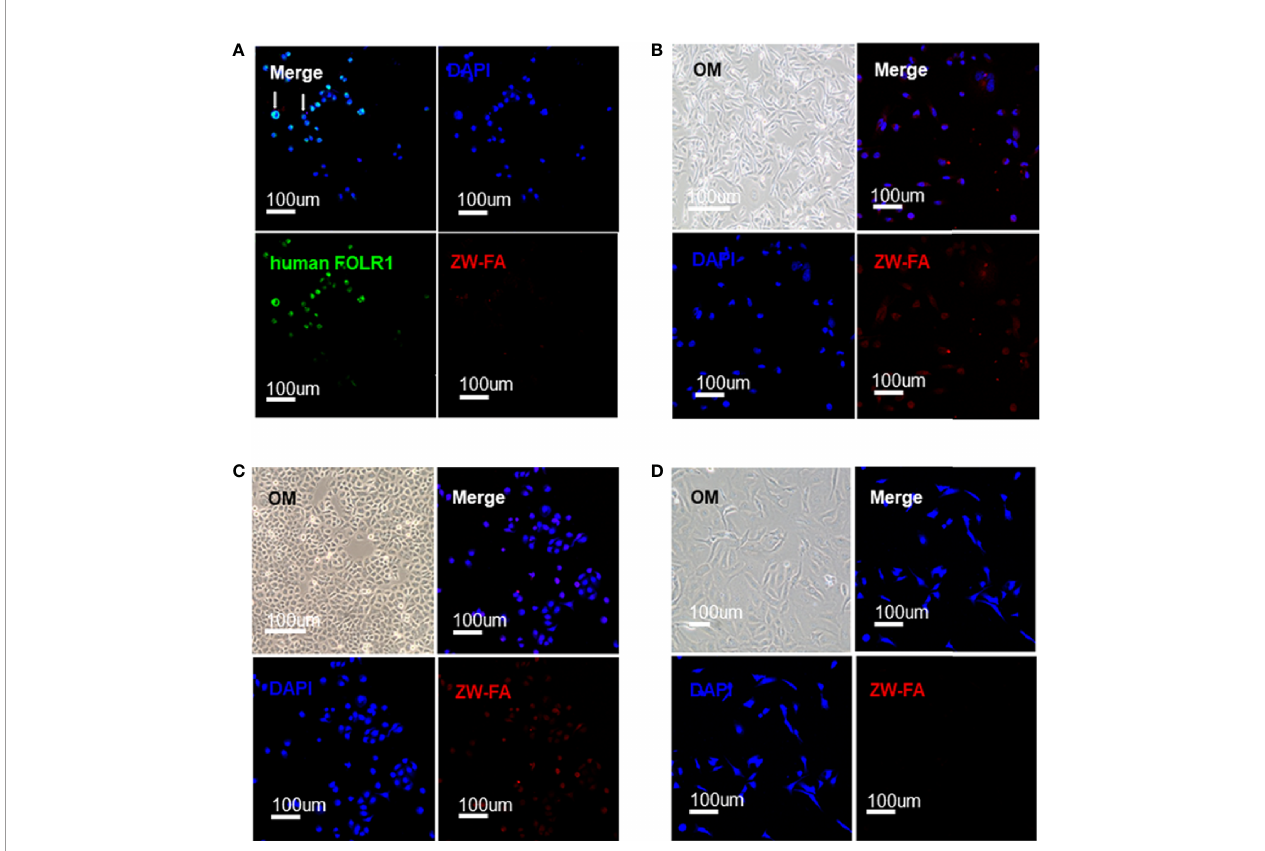
FIGURE 2 | Targeting veri fi cation. (A) Fluorescence images of SKOV 3 , cells were incubated with human FOLR1 antibody, ZW-FA and DAPI in sequence. (B) Fluorescence images of MDA-MB-231, cells were incubated with ZW-FA and DAPI in sequence. (C) Fluorescence images of SKOV 3 , cells were incubated with ZW-FA and DAPI in sequence. (D) Fluorescence images of HUVEC, cells were incubated with ZW-FA and DAPI in sequence. The concentration of ZW-FA was 600 ug/ml in the three cell lines. The excitation wavelengths of DAPI, human FOLR1 antibody and ZW-FA fl uorescence were 408 nm, 488 nm and 633 nm,